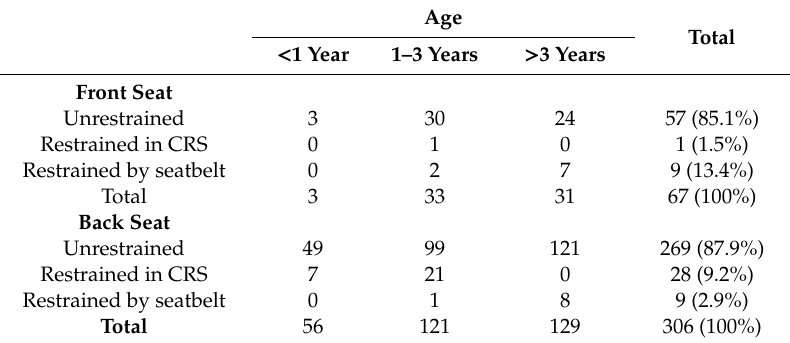
Table 2. Numbers of observed children stratified by age and seating position.